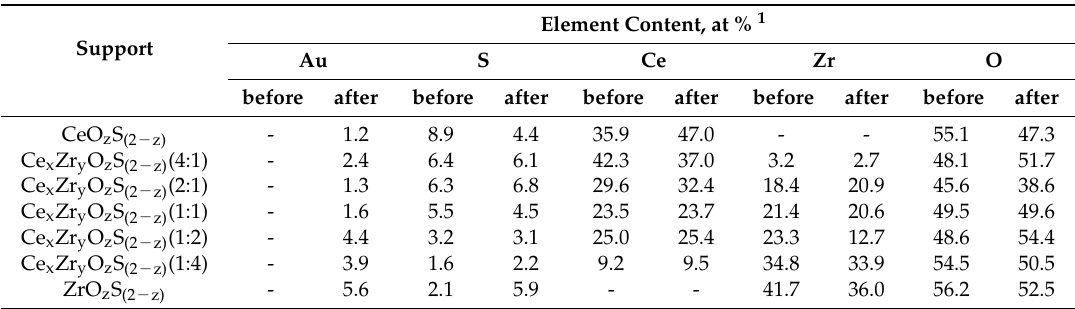
Table 6. The content of chemical elements on external surface before and after the modification of supports with gold species. Support before after before after before after before after before after before after before